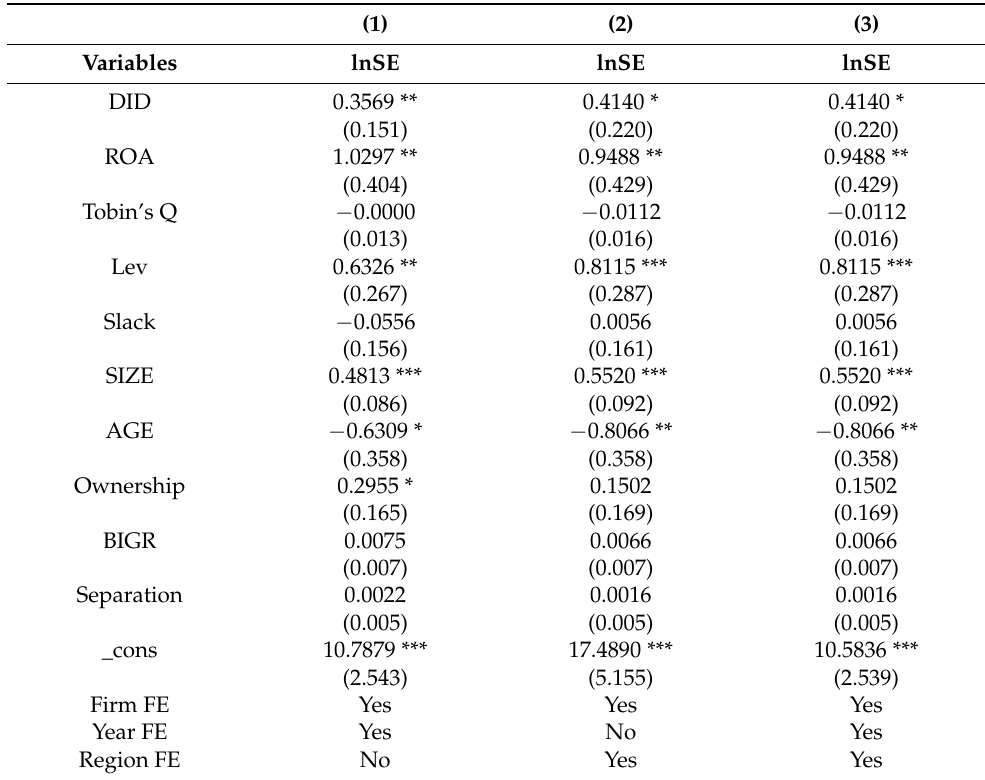
Table 7. Robustness Checks on Multi-period